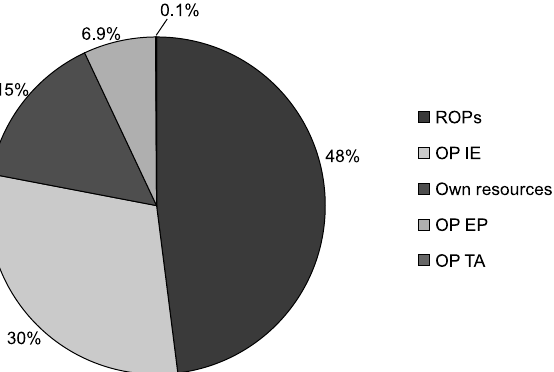
Fig. 3. Sources of financing of voivodeship ITIs with complementary